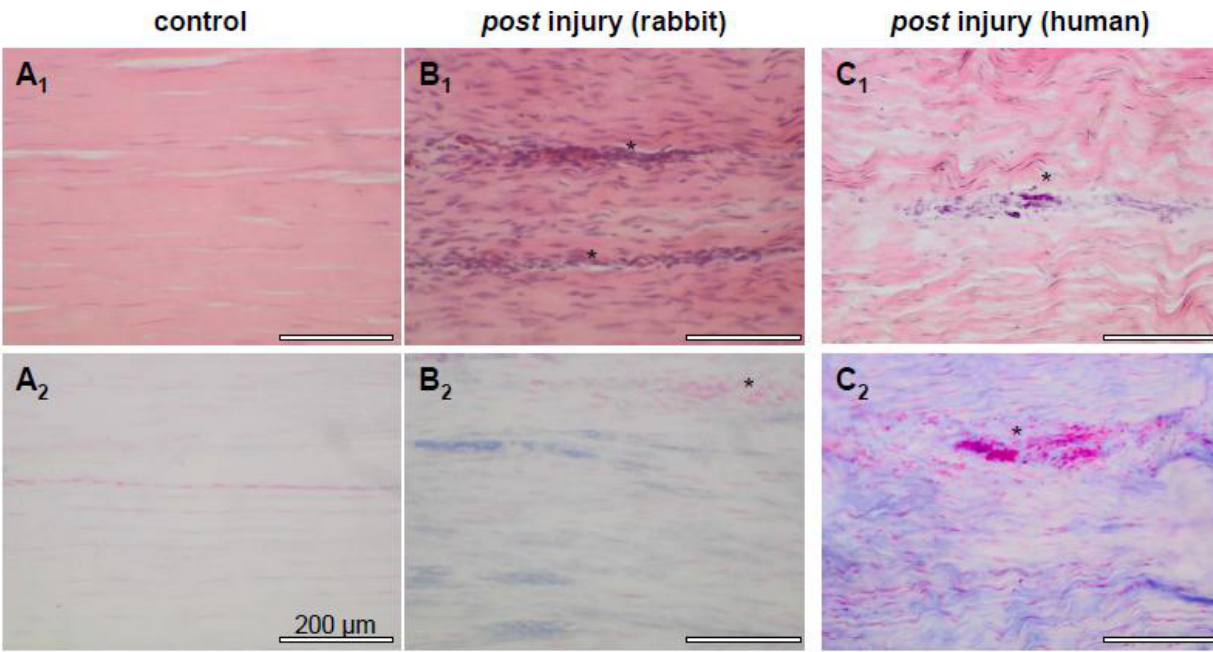
Figure 1. Tendon repair. Healthy rabbit Achilles tendon stained with haematoxylin eosin ). Elongated cell nuclei are visibly arranged in rows and surrounded by a dense (HE) ( A 1 ECM. For showing sulphated proteoglycans, alcian blue staining was performed ( A sulphated proteoglycans could hardly be detected. 6 weeks post injury (3 mm diameter tendon defect in the rabbit model), a hypercellularity with predominantly fibroblasts, an irregular and looser arrangement of ECM fiber bundles and multiple neo-vessels (asterisks) ). In addition, a focal increase in proteoglycan deposition ( B were evident ( B 1 detected. Human Achilles tendon several weeks after rupture stained for HE ( C alcian blue ( C 2 (cid:12)(cid:17)(cid:3)(cid:54)(cid:70)(cid:68)(cid:79)(cid:72)(cid:3)(cid:69)(cid:68)(cid:85)(cid:86)(cid:29)(cid:3)(cid:21)(cid:19)(cid:19)(cid:3)(cid:541)(cid:80)(cid:17)(cid:3)(cid:47)(cid:82)(cid:81)(cid:74)(cid:76)(cid:87)(cid:88)(cid:71)(cid:76)(cid:81)(cid:68)(cid:79)(cid:3)(cid:86)(cid:72)(cid:70)(cid:87)(cid:76)(cid:82)(cid:81)(cid:86)(cid:3)(cid:68)(cid:85)(cid:72)(cid:3)(cid:86)(cid:75)(cid:82)(cid:90)(cid:81)(cid:17)(cid:3)(cid:36)(cid:86)(cid:87)(cid:72)(cid:85)(cid:76)(cid:86)(cid:78)(cid:86)(cid:29)(cid:3)(cid:81)(cid:72)(cid:82)